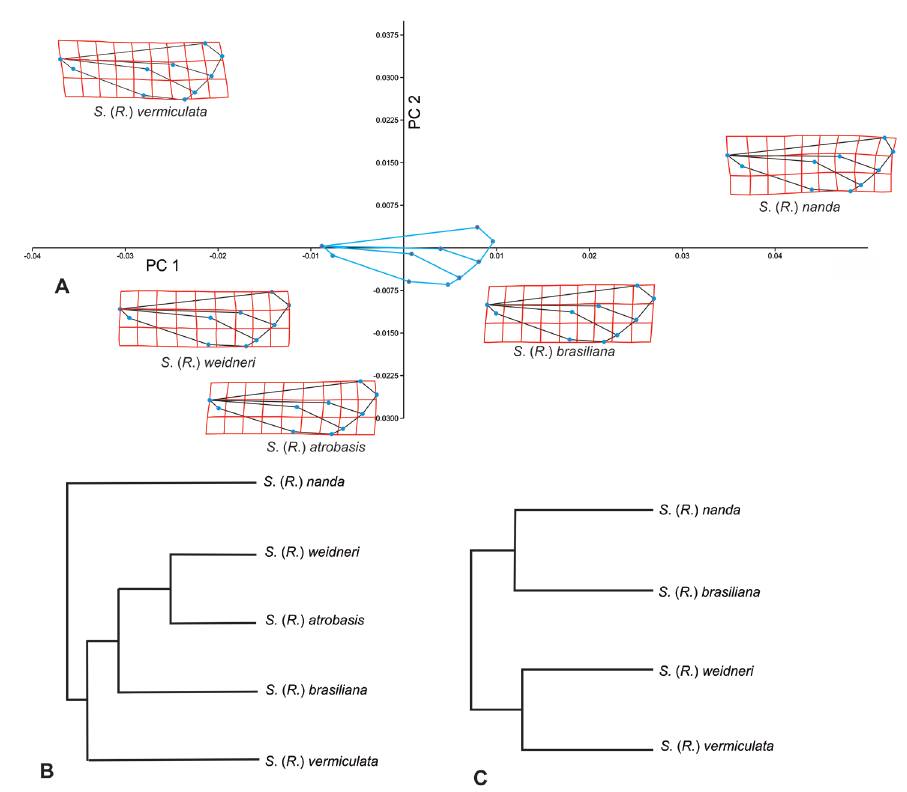
Figure 9. Principal Component Analysis (PCA) of the geometric landmark data of the wings of the brasiliana species group A scatter plot showing the average configuration of the wing shape in the defor- mation grids of each species from consensus shape of species group (indicate in the center of the plot) in the first two CPs. The circles represent the locations of the reference points in the mean shape of each species B UPGMA. Dendrogram from Mahalanobis distance of brasiliana species group and C without Smicridea ( Rhyacophylax ) atrobasis